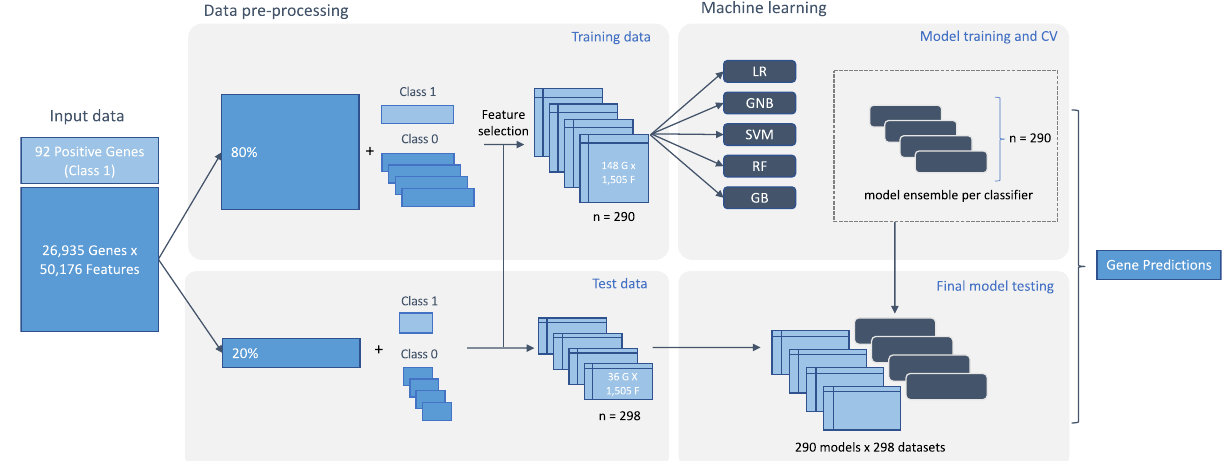
Fig. 1 Schematic representation of the analysis work fl ow. Previously known RNA methylation genes were used as positive samples (Class 1) and split into two sets comprising 80% of the data for training and 20% kept unseen for model testing. An analogous 80/20 split was performed for the remaining genes of the human genome, which were further divided into sets of equal size to the positive samples and used as negative samples (Class 0) to generate strati fi ed sets for feature selection, training and testing. Following feature pre- fi ltering, fi ve types of machine learning models for binary classi fi cation — Logistic Regression (LR), Gaussian Naïve Bayes (GNB), Support Vector Machine (SVM), Random Forest (RF) and Gradient Boosting (GB) — were trained on each of the training sets resulting in a classi fi er ensemble. Each model from the classi fi er ensemble was evaluated on each of the test datasets and overall performance was calculated by averaging results of all models across test sets. The best-performing ensemble was used to make predictions for the whole